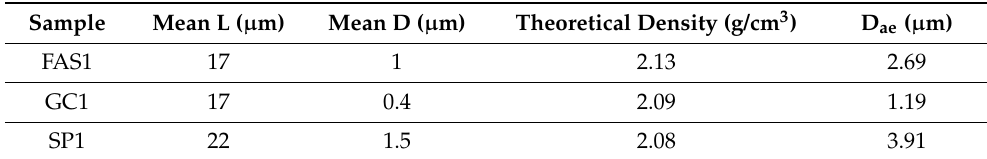
Table 5. Size parameters, theoretical density, and calculated aerodynamic diameter of studied mordenite